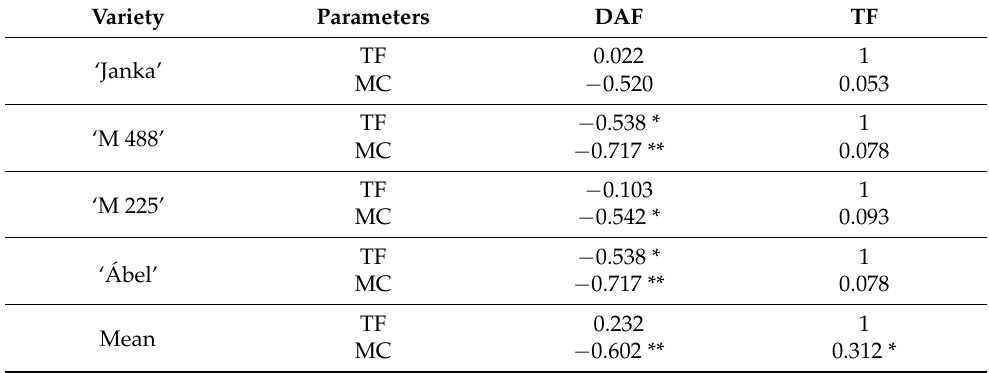
Table 7. Pearson correlation between days to flowering (DAF), threshing force (TF) values, and moisture content (MC) of three-year averages of ‘Janka’, ‘M 225’, ‘M 488’, ‘ Á bel’ and all variety together, respectively. * or ** means that correlation is significant at the 0.05 or 0.01 level (2-tailed).